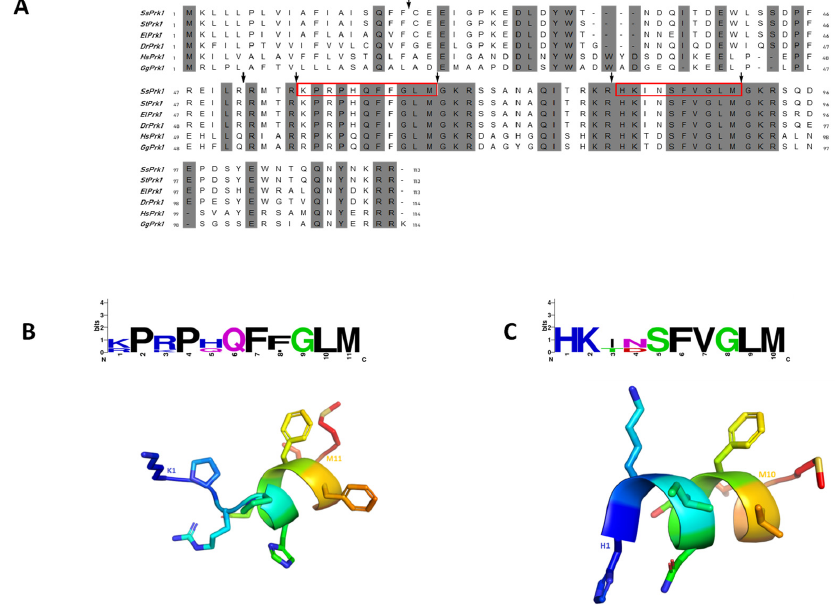
Figure 1. Characterization of prepro-tachykinin of S. salar and secondary structure modeling of mature peptides. ( A ) Amino acid sequence alignment of Prk1 of teleost species and vertebrates. The arrows indicate the putative protease cleavage, and red boxes indicate the Substance P (SP) and Neurokinin A (NKA) mature peptides. ( B ) PyMOL generated the overlapping model based on SP mature sequence. ( C ) PyMOL generated the overlapping model based on NKA mature sequence.